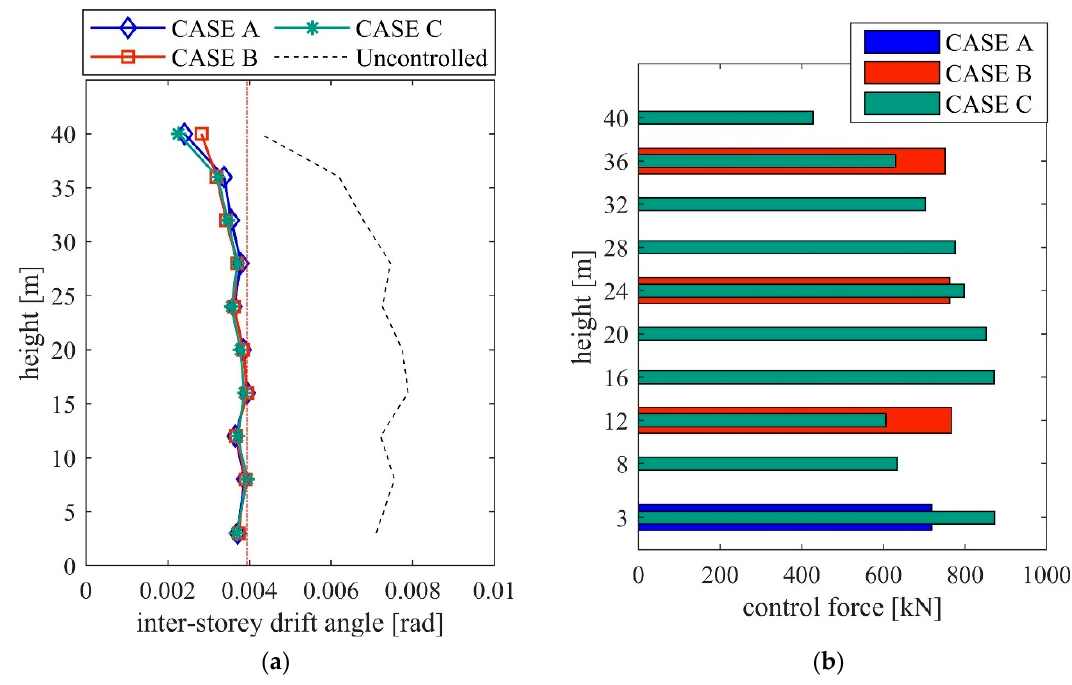
Figure 11. The root mean square (RMS) inter-story drift angle and the RMS control forces: ( a ) RMS inter-layer drift angles; ( b ) RMS control forces J of CASE A, CASE B and CASE C. Table 4. The cost index F